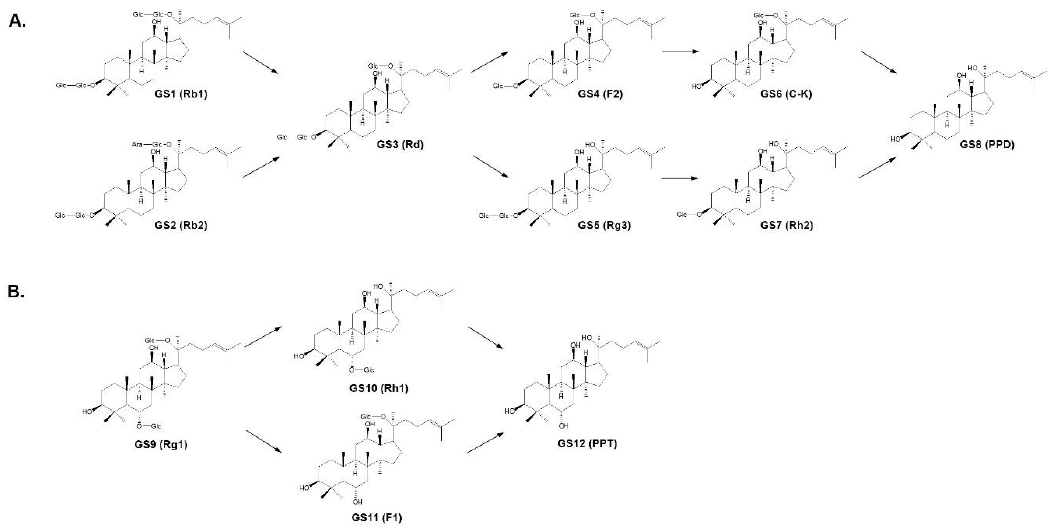
Figure 1. Metabolic processes of ( A ) protopanaxadiol-type ginsenosides (PDS) and ( B ) protopanaxatriol-type ginsenosides (PTS). GS1, Rb1; GS2, Rb2; GS3, Rd; GS4, F2; GS5, Rg3; GS6, Compound K (C-K); GS7, Rh2; GS8, protopanaxadiol (PPD); GS9, Rg1; GS10, Rh1; GS11, F1; GS12, protopanaxatriol (PPT).